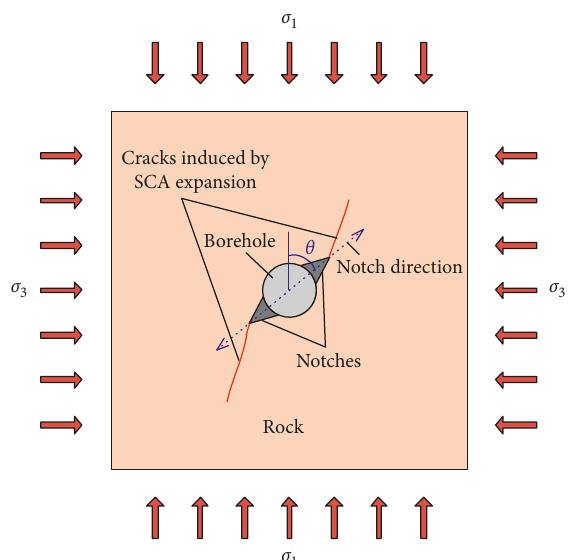
Figure 2: Schematic of notches around the SCA